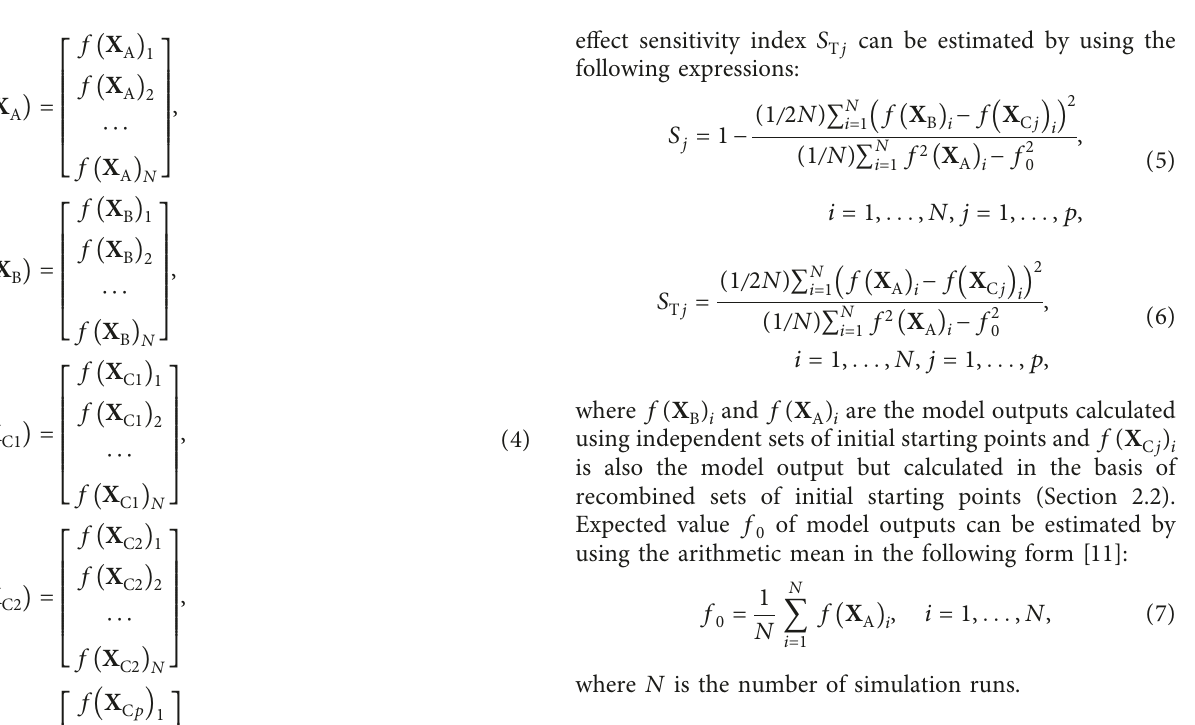
Figure 2: Two-dimensional representation of uniformly distributed random starting points at different numbers of simulation runs: N � 500 (a) and N � 2000